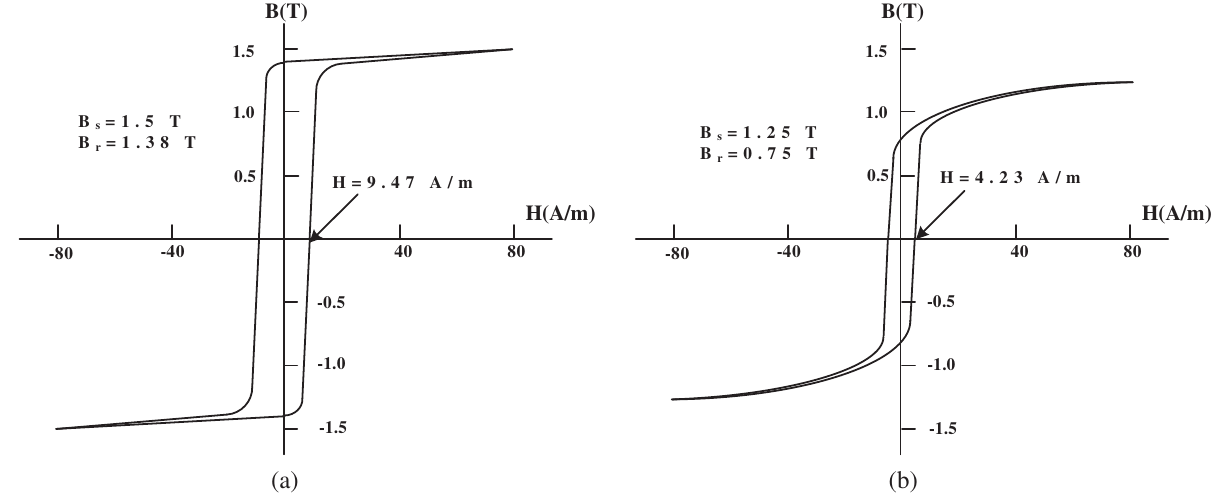
FIG. 5. DC B-H loops at 80 . 0 A = m of the magnetic cores of 2605SA1 (a) coated with SiO 2 film and (b) co-wound with 10 μ m capacitor tissue paper. Since the SiO 2 film is able to withstand the thermal annealing temperature at about 400 °C, the ribbons are annealed after coating. On the contrary, the capacitor tissue paper cannot withstand the high annealing temperature. The papers are wound with the ribbons after annealing.